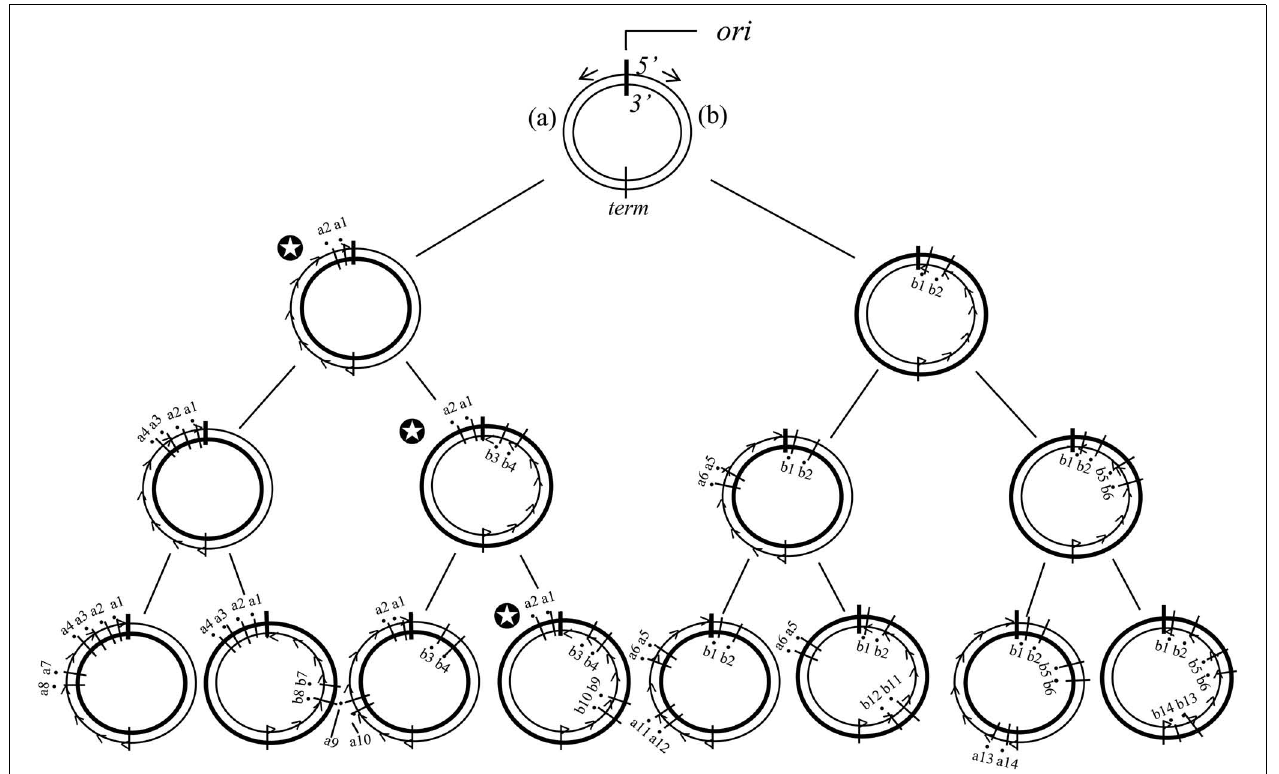
FIGURE 6 |The distribution of mutations according to the deterministic disparity model of a circular genome is shown. The ori is replication origin. DNA synthesis starts from the ori to opposite directions (short arrows). term , the position where the progress of DNA synthesis meets. (a) and (b) ,The left and right hemispheres of the genome, respectively. Broad circle indicates the template strand, and thin circle the newly synthesized strand.The thin circle